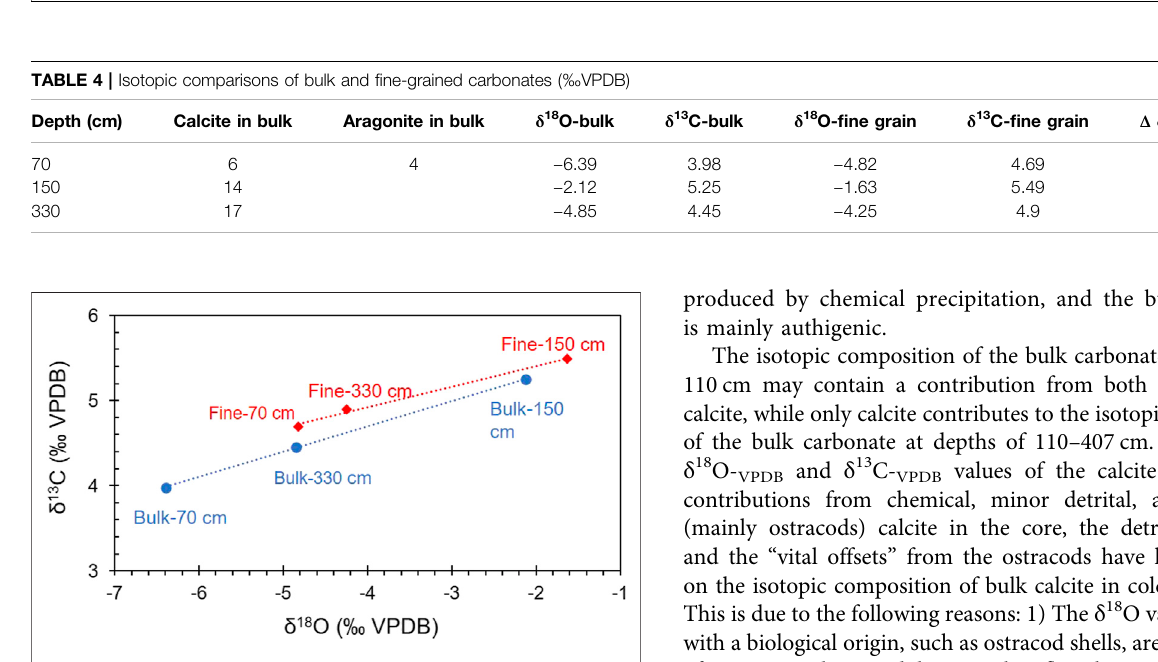
FIGURE 4 | Plot of ion content versus age showing the changes in the sedimentary environment and climate since 8.7 kyr BP.